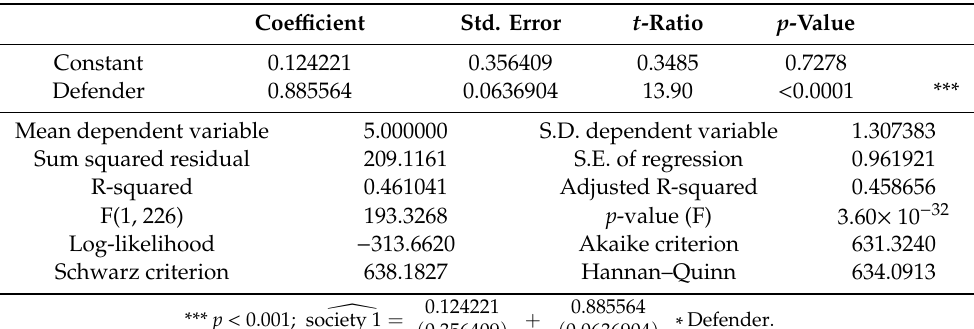
Table 5. Model 5: OLS, using observations 1–228. Dependent variable: Society 1.